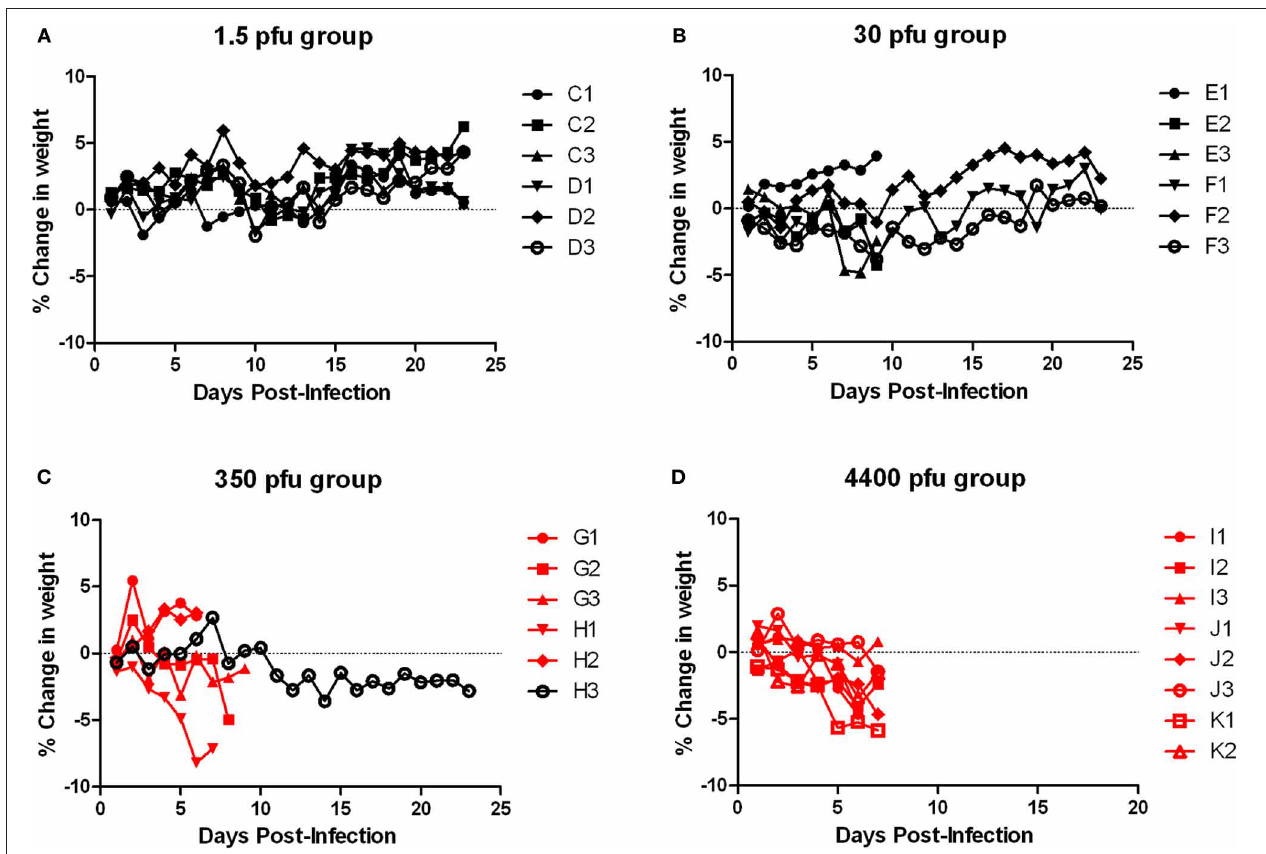
FIGURE 8 | Body weight of Lewis rats infected with aerosolized RVFV. Groups of six to eight female Lewis rats were infected with RVFV by the aerosol route at four doses plus uninfected controls. (A) 1.5pfu/rat; (B) 30pfu/rat; (C) 350pfu/rat; (D) 4400pfu/rat. The